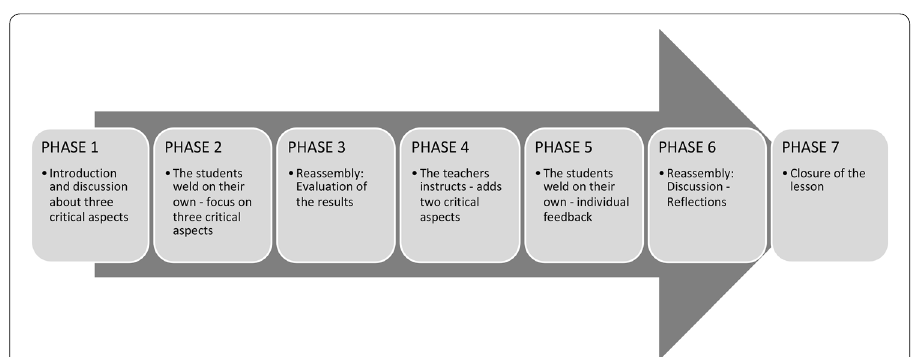
Fig. 3 Process of the lessons cycle